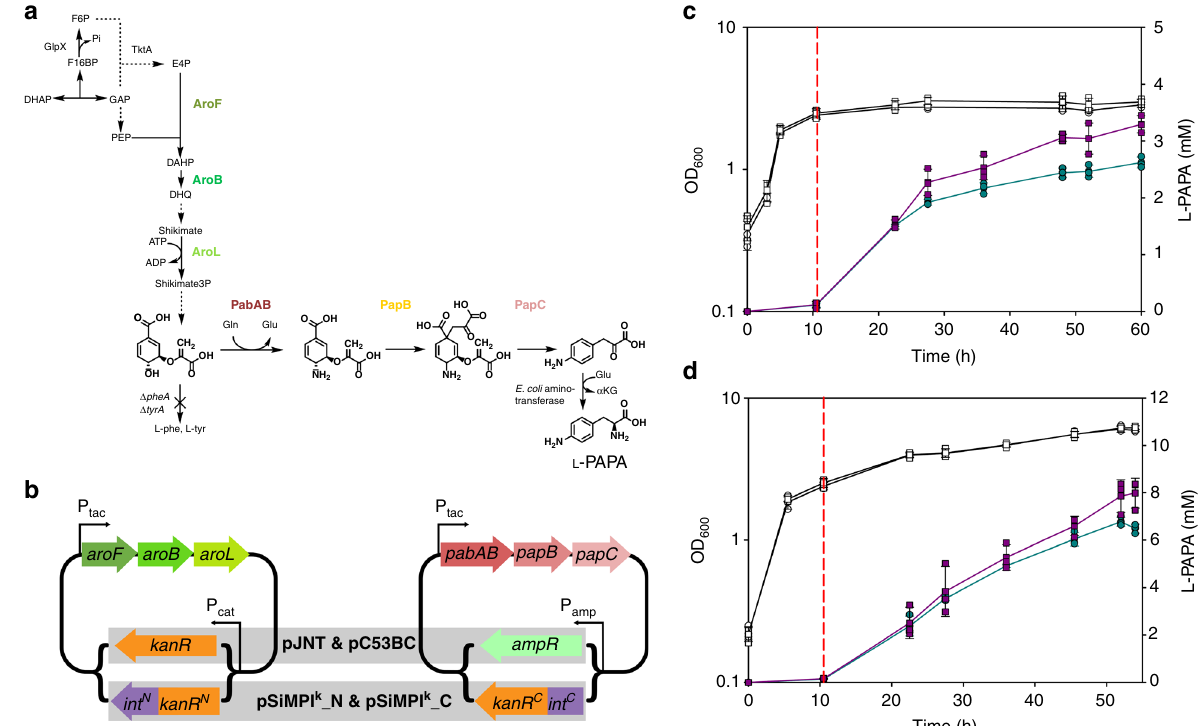
Fig. 7 SiMPl plasmids increase production of the non-proteinogenic aromatic amino acid L-PAPA. a Schematic showing the de novo L-PAPA biosynthesis pathway in E. coli . Broken arrows indicate incomplete presentation of the metabolic pathway. Plasmid-borne overexpressed enzymes are colored. AroF, DAHP synthase; AroB, dehydroquinate synthase; AroL, shikimate kinase; GlpX, fructose-1,6-bisphosphate phosphatase; PabAB, 4-amino-4- deoxychorismate synthase; PapB, 4-amino-4-deoxychorismate mutase; PapC, 4-amino-4-deoxyprephenate dehydrogenase; PheA, bifunctional chorismate mutase/ prephenate dehydratase; TktA, transketolase A; TyrA, bifunctional chorismate mutase/ prephenate dehydrogenase. b Schematic showing the plasmids used in ( c ) and ( d ). c , d L-PAPA production in E. coli FUS4.7 R cells cultivated in fl asks ( c ) or in a bioreactor ( d ). Optical density (OD 600 ) is shown in white. L-PAPA concentration in violet and green. Circles, production from cells co-transformed with pC53BC and pJNT- aroFBL; Squares, production from cells co-transformed with pC53BC_SiMPl k _C and pJNT- SiMPL k _N; Vertical dotted line, time at which production is initiated by addition of IPTG (0.5 mM fi nal concentration). Values represent mean (± standard deviation) of three independent experiments. Source data are provided as a Source Data fi le